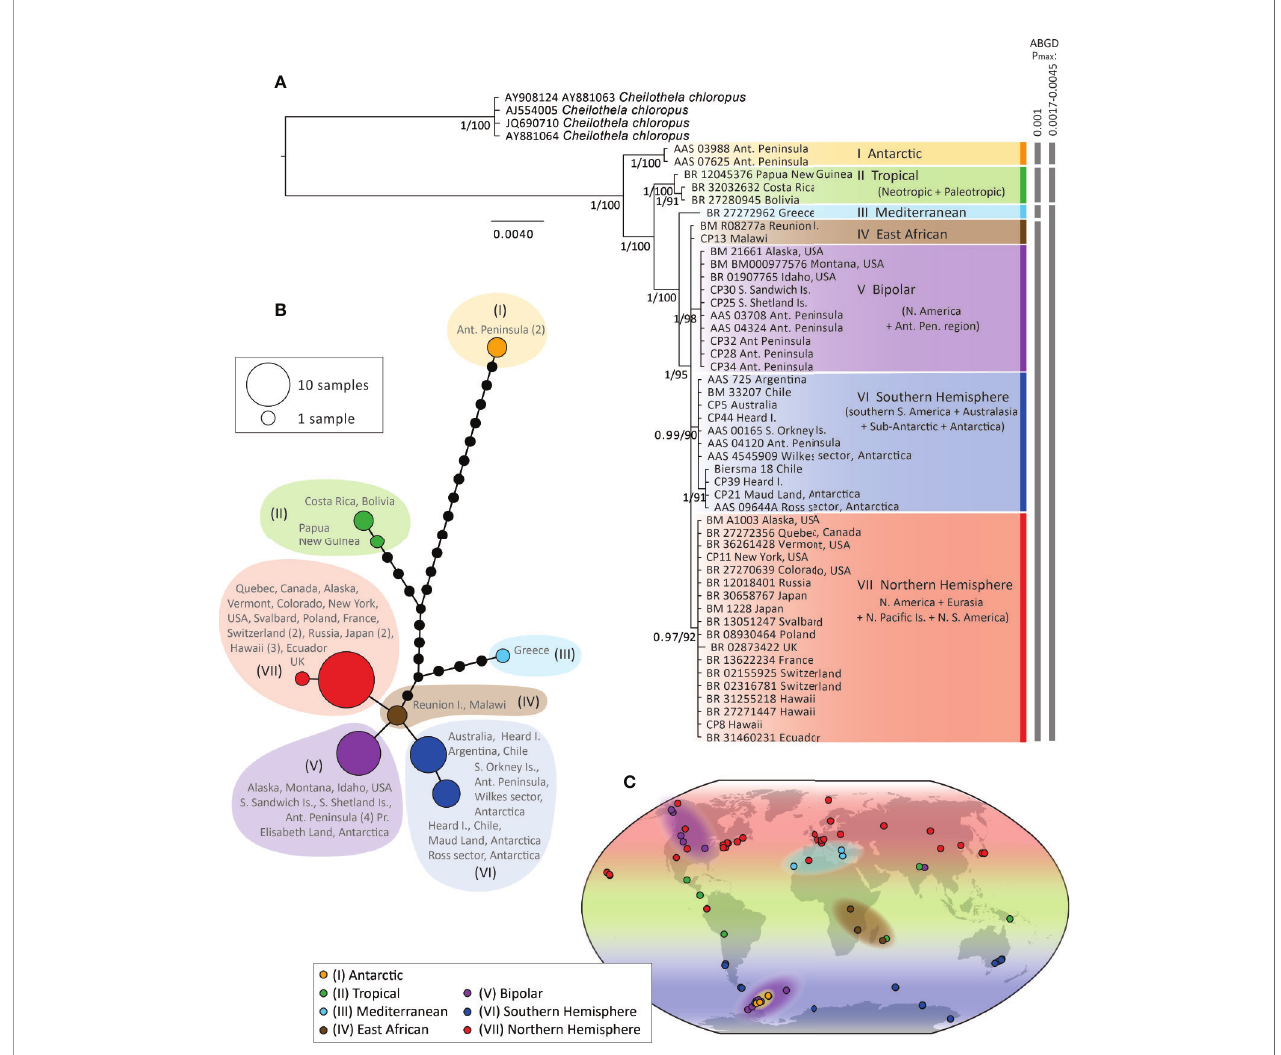
FIGURE 2 | Bayesian phylogeny (A) and haplotype network (B) for Ceratodon purpureus constructed with a concatenated cpDNA data set ( atpB-rbcL + rps4 + trnL-F ). Posterior probabilities and bootstrap support are shown next to branches (A) . The scale bar represents the mean number of nucleotide substitutions per site. Biogeographic clade descriptions (I – VII) and ABGD species-clusters with different P max -values are shown next to (A) . In (B) haplotype circle sizes and colors correspond to the number of specimens and clades I – VII, respectively. Branches represent mutations between haplotypes, with mutations shown as 1-step edges. (C) represents the sample locations and biogeographic regions of samples in the different clades (I – VII) as interpreted from the concatenated cpDNA data set (A) , as well as the placement of samples in phylogenies of single cpDNA markers (e.g. when samples were only represented by one or two single cpDNA marker(s);